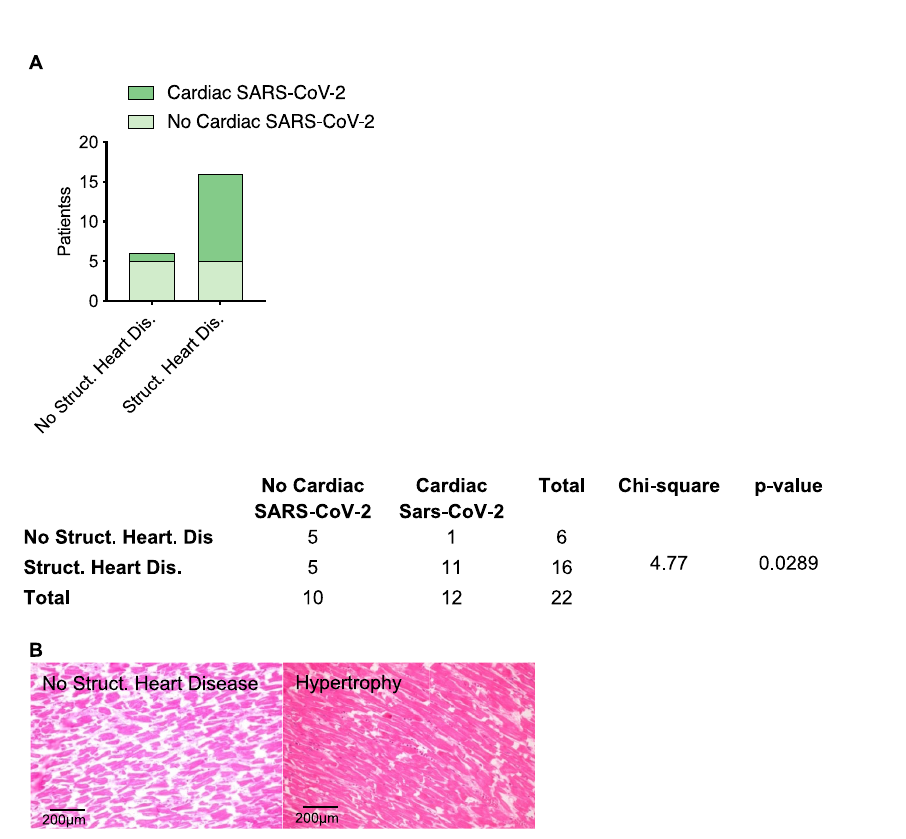
Fig. 2 Histopathological signs of cardiac hypertrophy in correlation to SARS-CoV-2 infections. A Patients suffering from structural heart disease showed higher rates of cardiac SARS-CoV-2 infections. ( p = 0.0289, Chi-square test). B Representative histopathological images of Hematoxylin/Eosin stained tissue sections from hypertrophic and non-hypertrophic